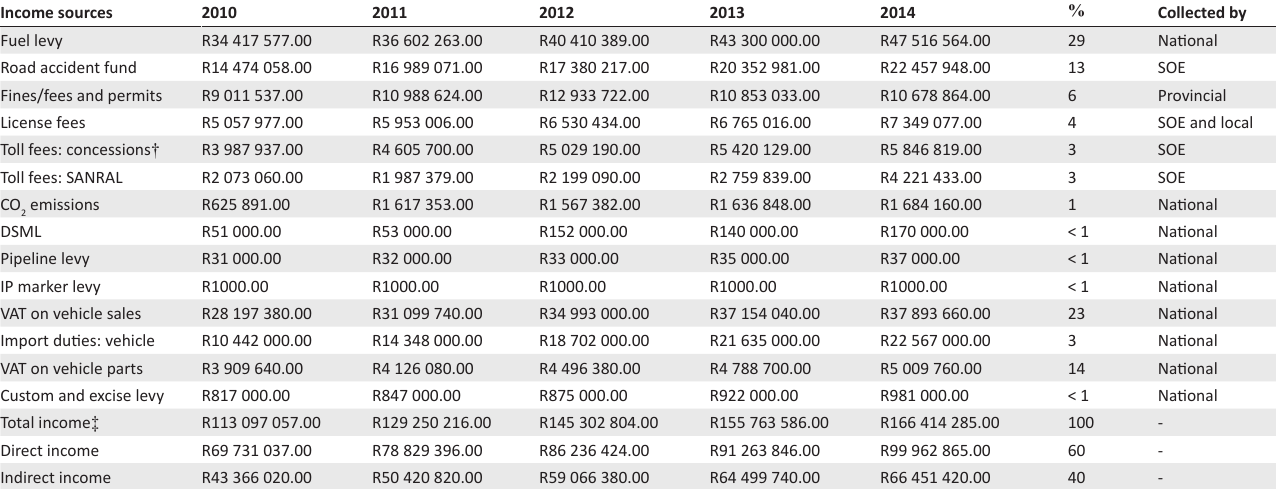
TABLE 1: Road-generated income